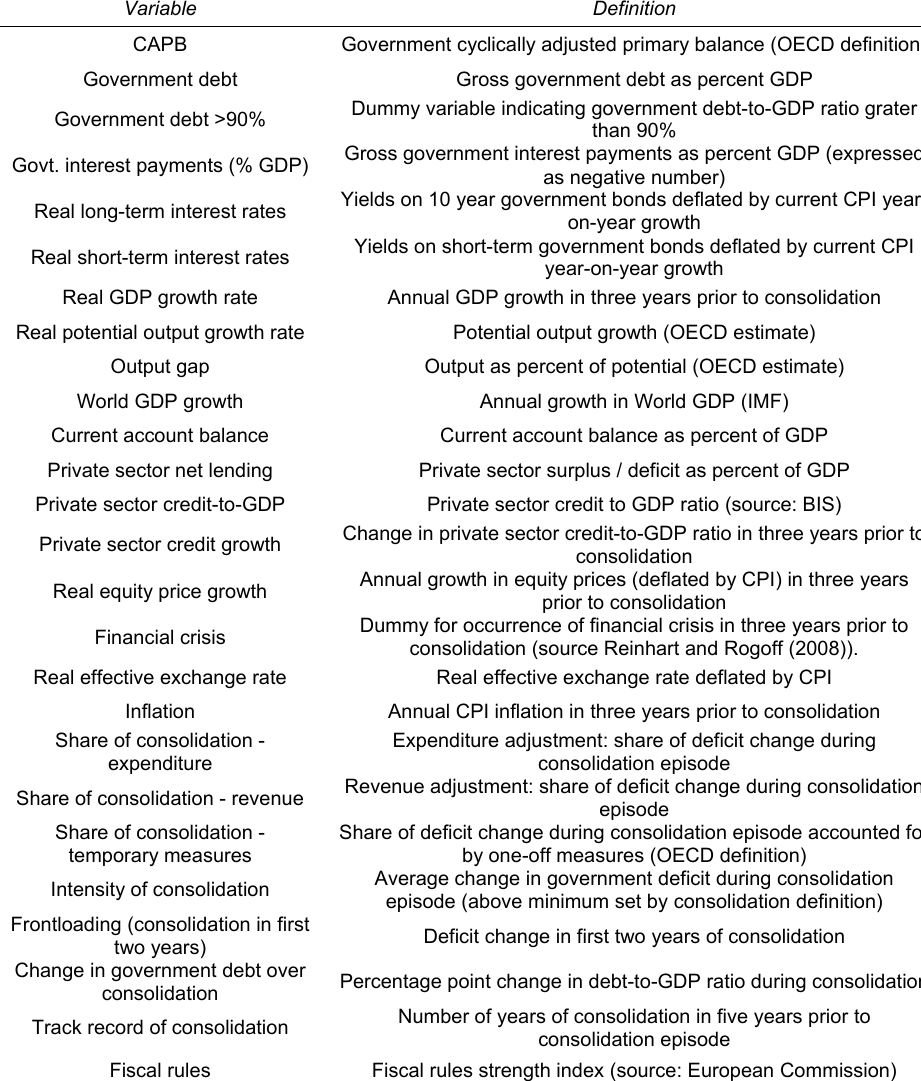
Table 3: Definitions of variables used in duration